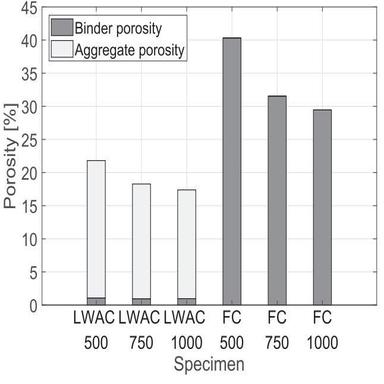
Porosity of the LWC specimens.